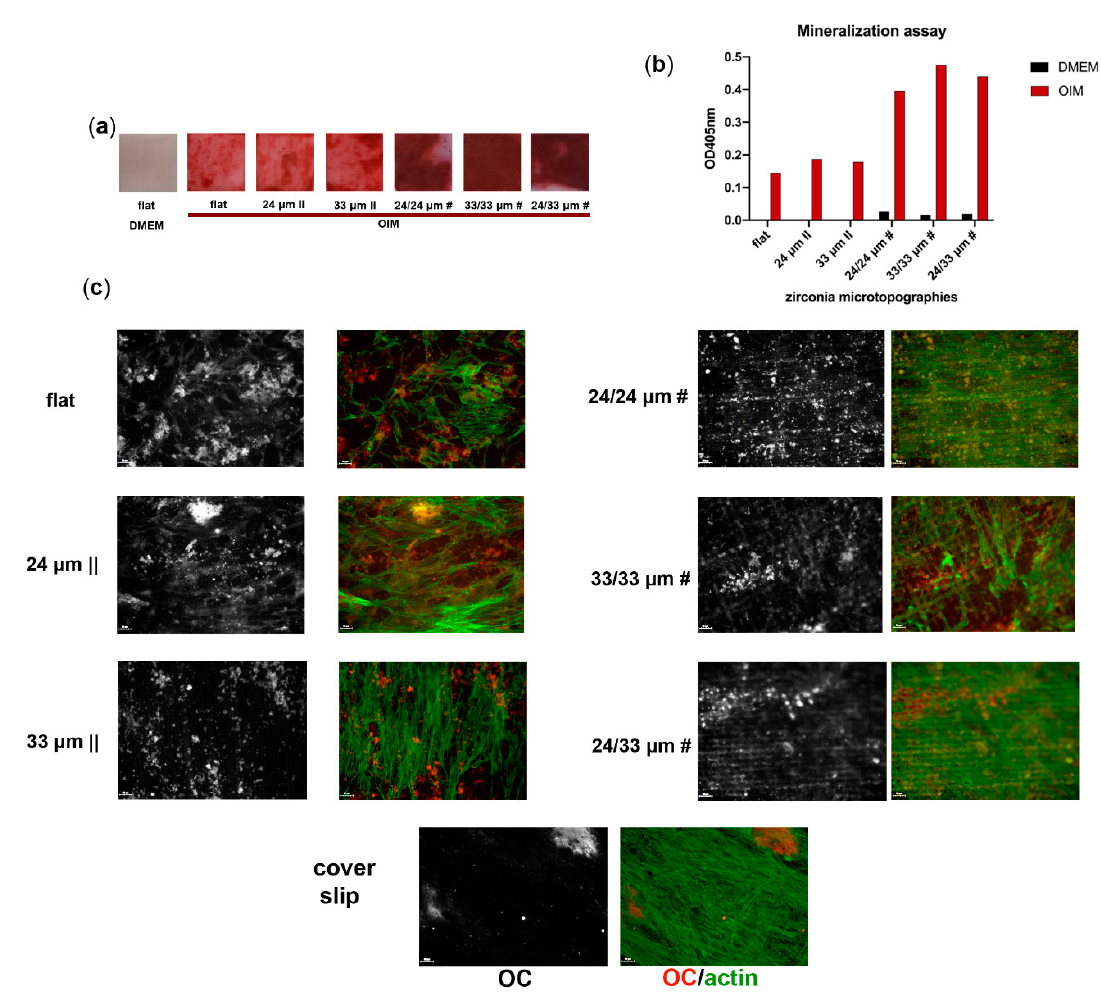
Figure 9. Osteogenic differentiation of human mesenchymal stem cells (hMSCs) onto Zirconia microtopographies. Alizarin Red staining ( a ) and quantification ( b ) for hMSCs cultured for 28 days in osteoinductive media conditions (OIM) versus control (DMEM). Immunofluorescence images of cells on Zirconia bio-interfaces expressing the osteoblast marker osteocalcin at the end of the di ff erentiation process ( c ). The fluorescence images ( c ) were obtained upon labeling with antibodies for osteocalcin (red) and staining of actin filaments with Alexa Fluor 488-Phalloidin (green). Image acquisition was performed using the TissueFAXS iPlus automatic